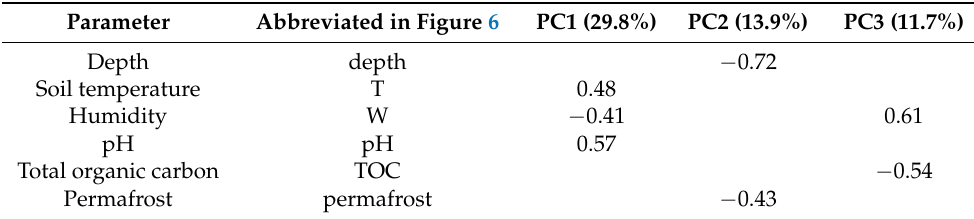
Table 4. Principal component analysis showing the principal components (PC), their explained variance and loadings of the parameters used in the PCA ordination. Parameter Abbreviated in Figure 6 PC1 (29.8%) Depth